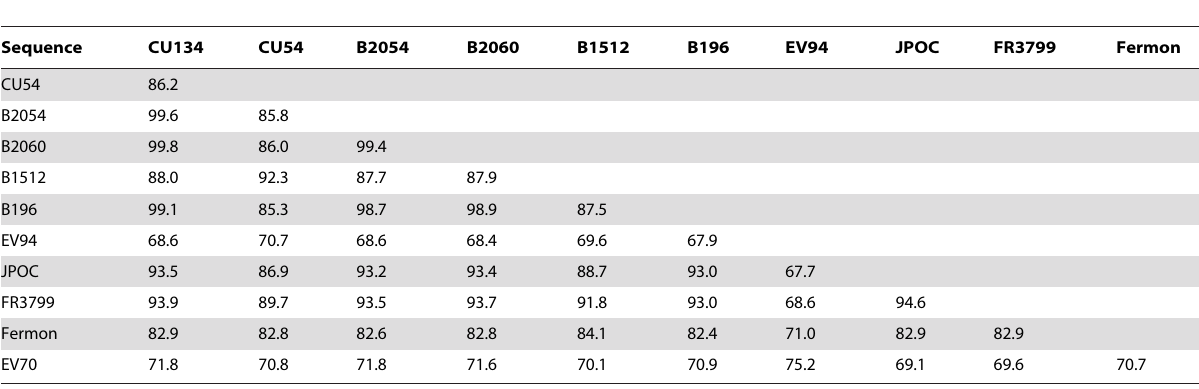
Table 2. Nucleotide identity matrix obtained for the alignment of 5UTR 9 /VP2 region of EV68 identified from Thailand and reference strains of EV68 and other members of enterovirus species D (EV94 and EV70).